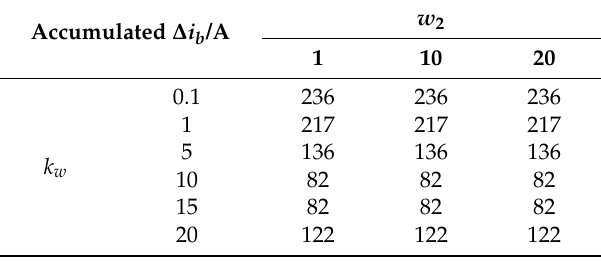
Table 8. LiB accumulated ∆ i b under different k w and w